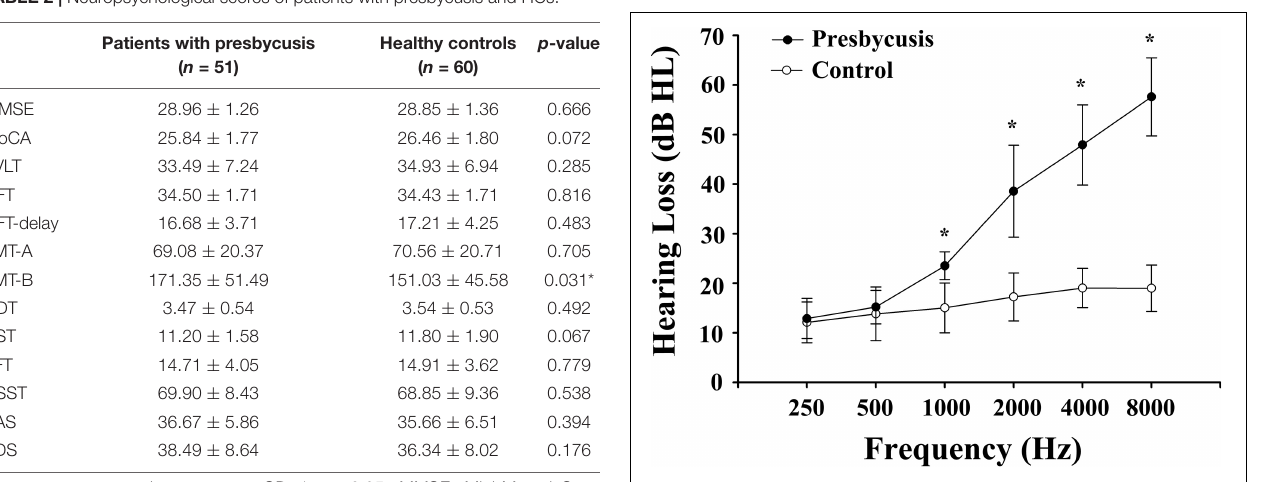
Patients with presbycusis ( n = 51)